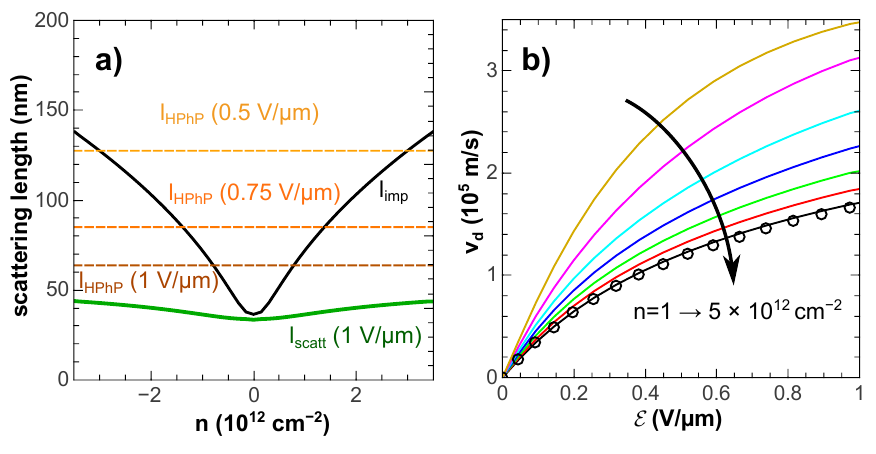
Figure 3. ( a ) Scattering length associated with the impurity scattering (black solid line) responsible for the low field mobility; here µ = 10 4 cm 2 /V/s, and with the HPhP scattering (dashed lines) for different in plane electric fields E = V 0 / L . The green thick line is the total scattering length at the largest bias ds obtained by the Matthiessen’s law. ( b ) Carrier drift velocity simulated using v d = V 0 / ( RneW ) with R ds from Equation (1), and the measured drift velocity at large doping ( n = 5 × 10 12 cm − 2 ) in black